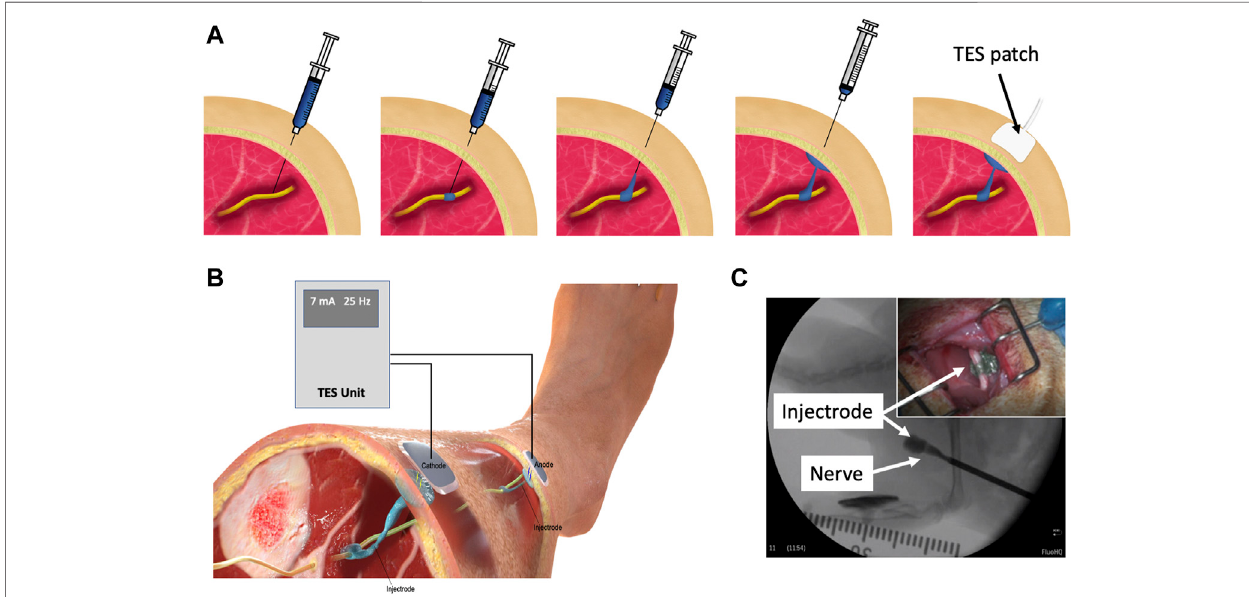
FIGURE1|(A) DeliveryprocedureoftheInjectrodesystem.TheInjectrodeisinjectedontoaneuralstructure.AsyringecontainingtheInjectrodeisdeployedtothe targetnerveunderimageguidance.TheInjectrodeisdeployedtoformaninterfacewiththenerve.ThesyringeisthendrawnbackwhileinjectingtheInjectrode – toforma conductive path from the deep nerve toskin. More Injectrode material is then injected under the skin to form a ‘ collector ’ . An externally placed TES patch electrode non- invasivelydeliverschargetotheInjectrode. (B) Injectrodesysteminbipolarcon fi